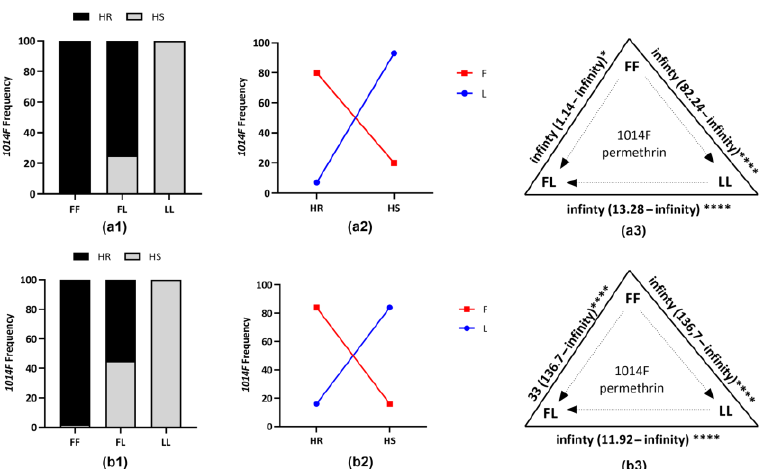
Figure 2. Correlation between L1014F kdr and permethrin-resistance phenotype in An. coluzzii and An. gambiae from F4. ( a1 , b1 ) Distribution of kdr L1014F genotypes in dead and alive F4 mosquitos from An. coluzzii and An. gambiae crossings, respectively, after WHO bioassays with 0.75% permethrin. ( a2 , a3 , b2 , b3 ) Association between frequency of 1014F and ability of F4 mosquitos, respectively, from An. coluzzii and An. gambiae crossings to survive to WHO bioassays with 0.75% permethrin, showing a very strong link between 1014F kdr mutation and permethrin-resistance phenotype. HR, Highly resistant; HS, Highly susceptible; FF, homozygous resistant; FL, heterozygous resistant; LL, homozygous susceptible; F, resistant allele (L1014F); L, susceptible allele (L1014). Significance is shown by * p < 0.05, **** p < 0.0001, as estimated using Fisher’s exact test.